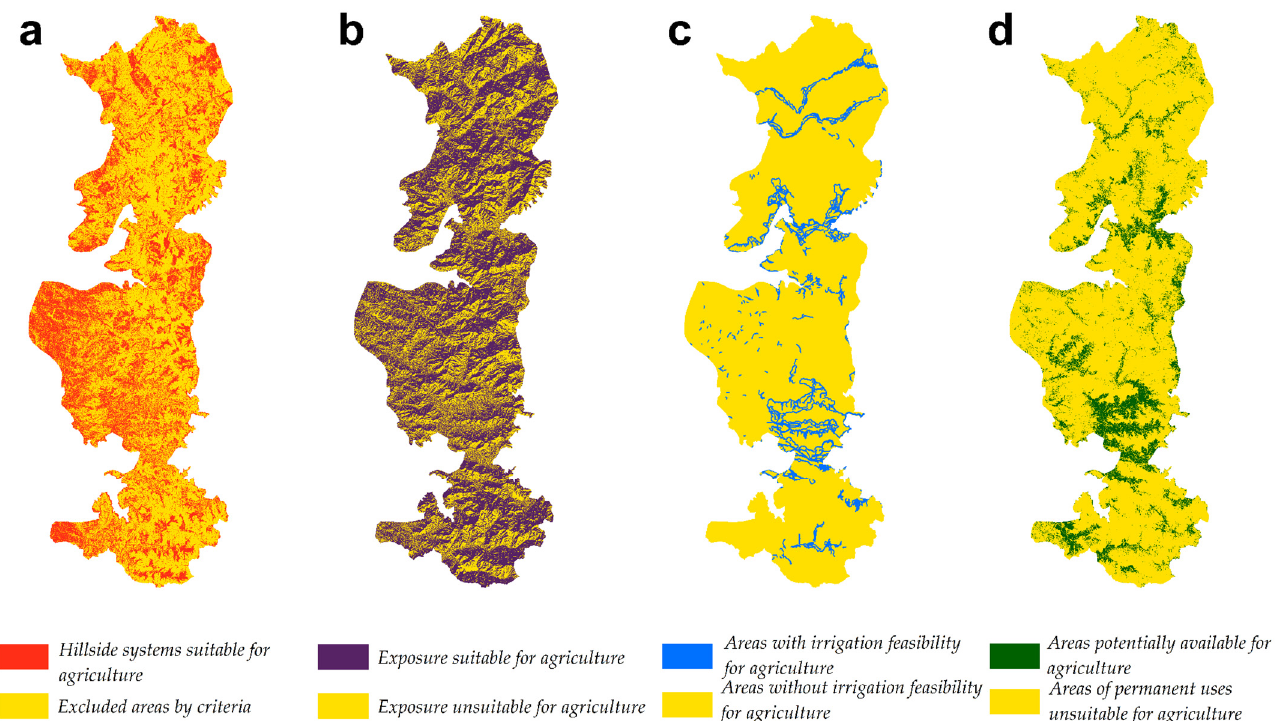
Figure 5. Spatial representation of the criteria used for the integrated analysis of hillside systems: ( a ) shows the hillside systems suitable for agriculture; ( b ) shows the exposure suitable for agriculture; ( c ) shows the areas suitable for agriculture according to the feasibility of irrigation; and ( d ) shows the areas potentially available for agriculture because they do not have other permanent uses. The yellow color represents the excluded areas according to the selected criteria.